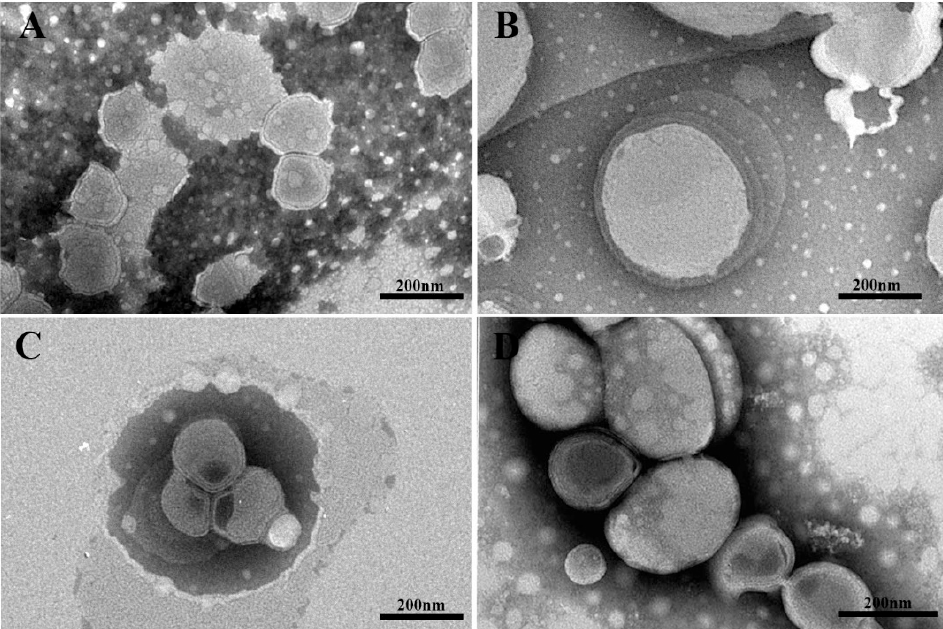
Figure 2. TEM micrographs of representative niosomes negatively stained with sodium phospho- tungstate. Uncoated T niosomes (panel ( A )) and HA-coated Tween 20 niosomes (Panel ( B) , sample T 1:1). Uncoated S3 (Panel ( C )) and HA-coated Span-based niosomes (Panel ( D) , sample S3 1:0.5).